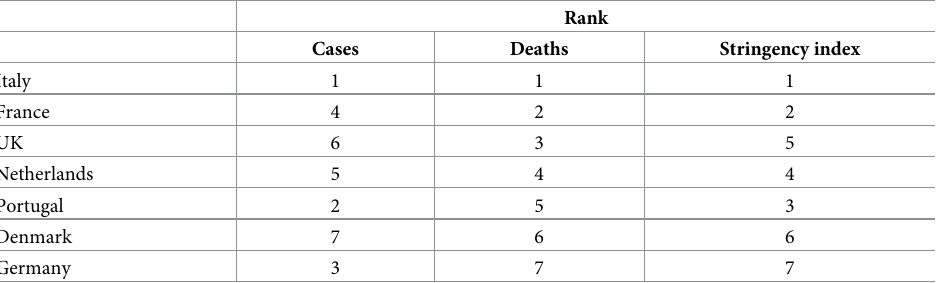
Table 1. Relative ranking of countries according to the severity of the pandemic and stringency of containment measures. Rank Cases